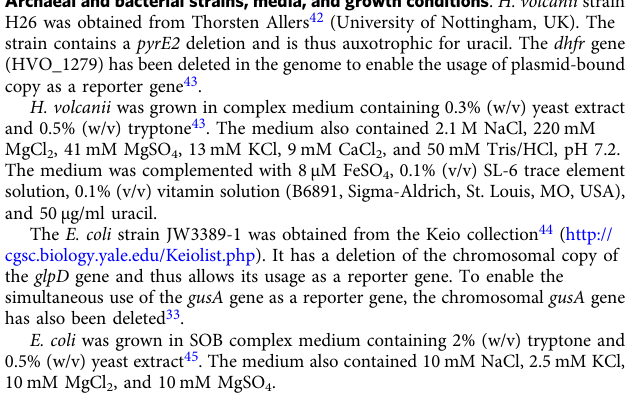
Table 3. The fragments contained 99 nt of the upstream gene and 30 nt of the downstream gene. They were cloned into the vector using the restriction sites NcoI and XhoI . The oligonucleotides that were used to exchange the SD motifs with unrelated sequences are shown in Supplementary Table 4. For the mutagenesis the cloned gene pairs were subcloned from the shuttle plasmids into the vector pSK + to reduce the plasmid size. The quickchange site directed mutagenesis kit was used to introduce the mutations (www.agilent.com). Then the altered fragments were cloned back into the shuttle vector. After all PCR, cloning and mutagenesis steps the DNA sequences were veri fi ed. Quanti fi cation of speci fi c reporter enzyme activities . The activity of the DHFR reporter enzyme was quanti fi ed with an enzymatic assay 30 . In short, the oxidation of NADPH by dihydrofolic acid was followed at 340nm, and an extinction coef- fi cient of 6.22 mM − 1 cm − 1 was used to calculate the activity. The assay